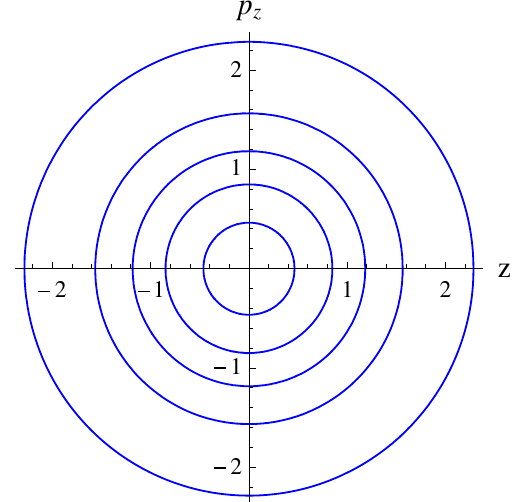
FIG. 1. Bunch longitudinal Gaussian distribution inside a linear potential well presented by equally populated nested airbags; the coordinate z and momentum p are measured in their rms units. z Note that the radii are not